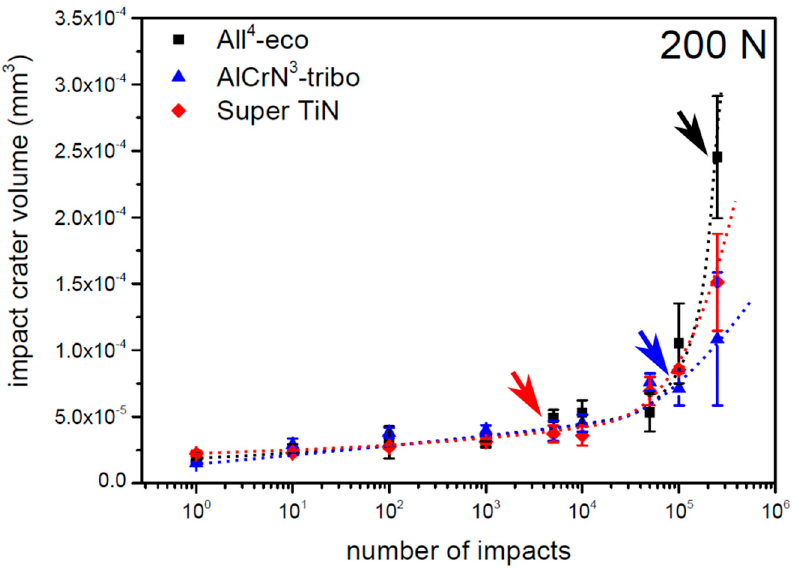
Figure 5. Loading curves of tested PVD coatings obtained by a load of 200 N. Arrows indicates number of impacts where the first cracks appeared.